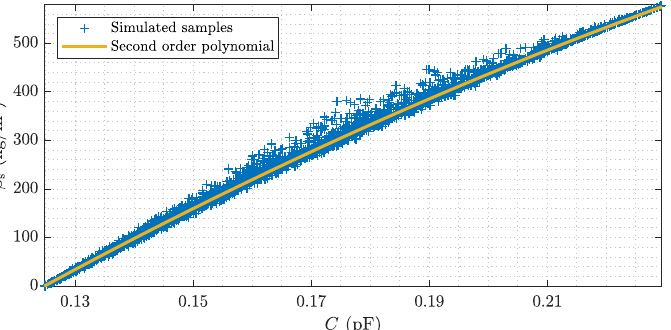
Figure A1. Model based determination of the empirical sensor characteristics, which describe the relationship between the capacitance of a two electrode sensor and the cross-sectional average mass